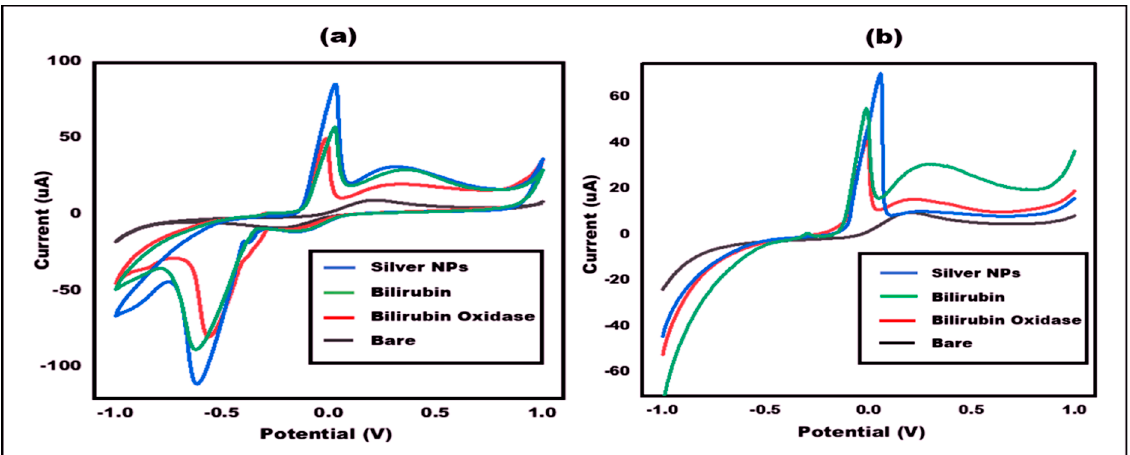
Figure 4. ( a ) Cyclic voltammetry of 10 mM PBS at bare ePAD, Ag-NPs/ePAD, Enzyme/Ag-NPs/ePAD, Bilirubin/enzyme/Ag-NPs/ePAD at 50 mVs − 1 in the potential range from − 1 V to +1 V. ( b ) LSV, in the range of − 1 V to +1 V for 10 mM ferro/ferri in PBS at 50 mVs − 1 at bare ePAD, Ag-NPs/ePAD, Enzyme/Ag-NPs/ePAD,